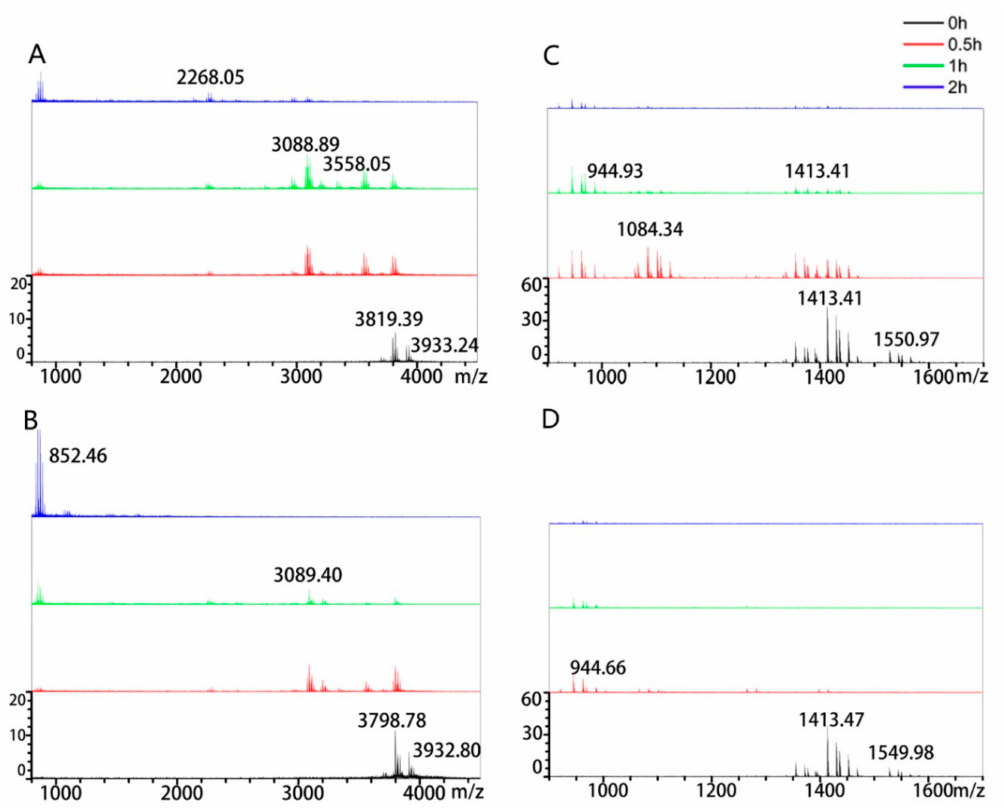
Figure 4. MALDI–TOF analysis of the degradation profiles of the 33-mer and 13-mer gliadin peptides. The 33-mer (1.0 mg/mL) gliadin peptide was incubated with B. cereus AFA01 from the medium of MCG-1 ( A ) or SCB ( B ) for 0, 0.5, 1 and 2 h. The 13-mer gliadin peptide (0.25 mg/mL) was incubated with B. cereus AFA01 from the medium of MCG-1 ( C ) or SCB ( D ) for 0, 0.5, 1 and 2 h,